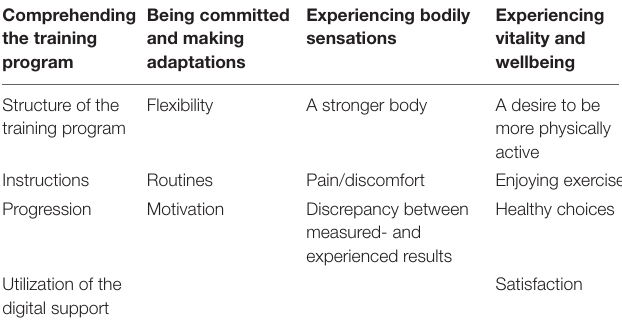
TABLE 3 | Categories and sub-categories building the overall theme: “ Engaging in Digital Resistance Training by Personal Adaptation Leads to a Sense of Strength and Vitality